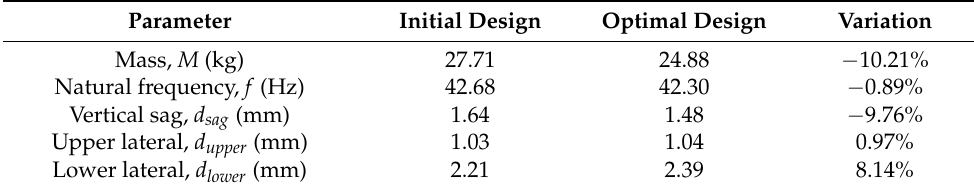
Table 8. Comparison of door weight and dynamic performance before and after optimisation.